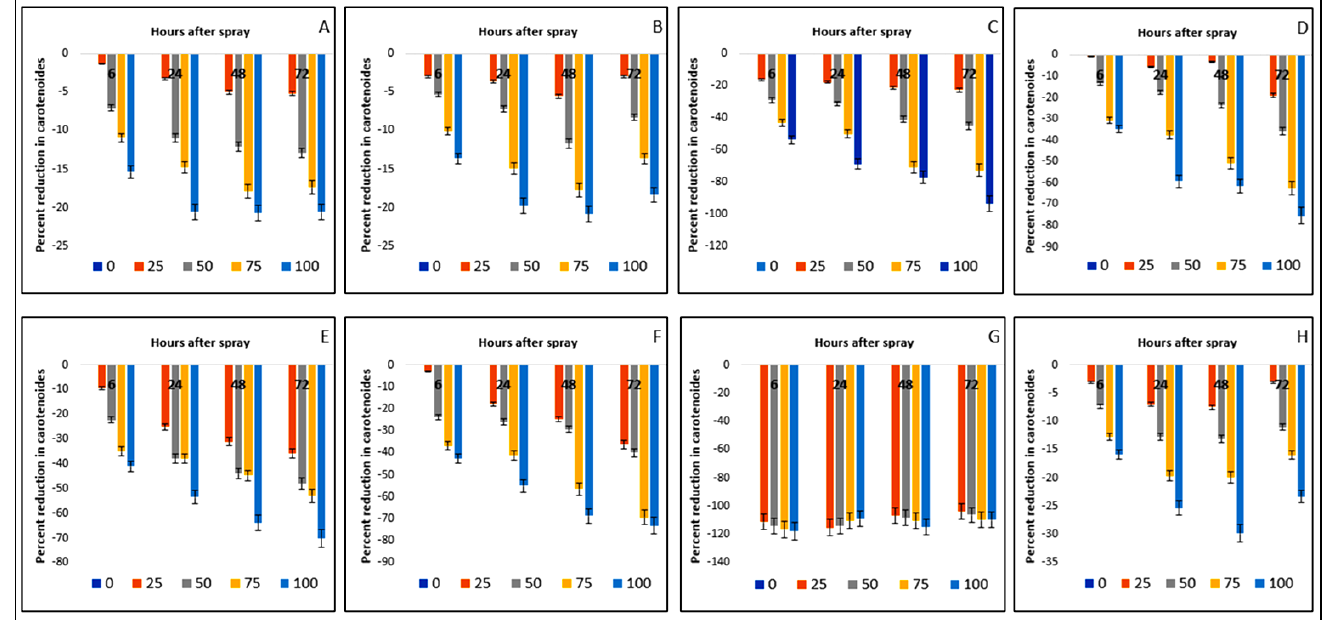
Figure 7. Reduction (%) of carotenoids due to the effect of parthenium leaf methanol extract on several crops and weeds: ( A )—Bambara groundnut; ( B )—Maize; ( C )— D. sanguinalis ; ( D )— E. indica ; ( E )— A. conyzoides ; ( F )— C. iria ; ( G )— E. hirta , and ( H )— C. difformis